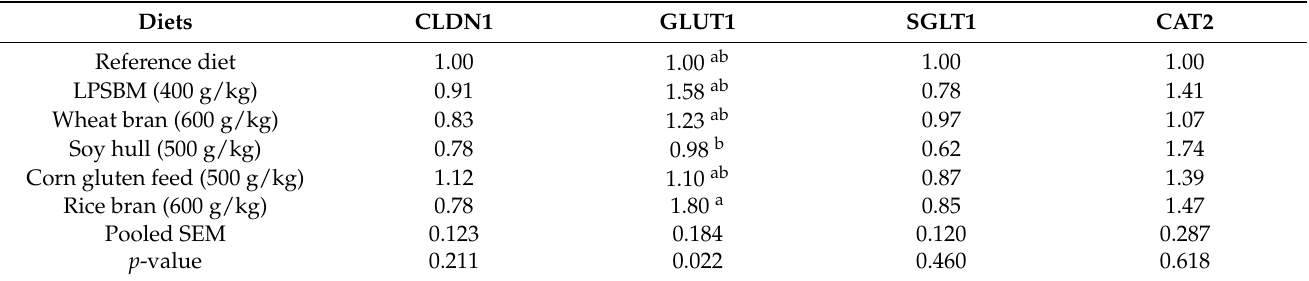
Table 8. Gene expression in the jejunum of 21-day-old broilers in response to short-term feeding of high levels of high-protein or high-fiber feedstuffs in a corn–soybean meal reference diet during metabolizable energy